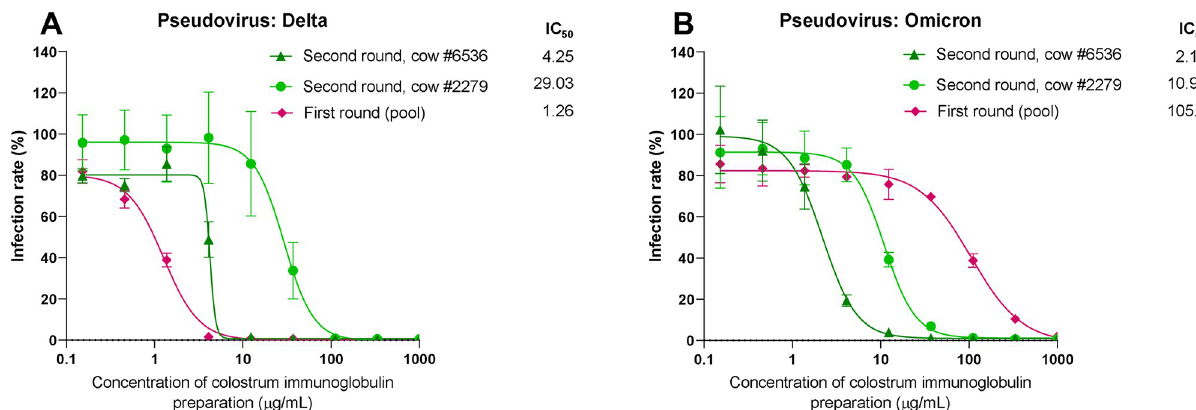
Fig 6. As in Fig 3, the results of the pseudovirus neutralization assay are depicted. Here, pseudoviruses were pseudotyped with either Delta or Omicron VoCs of the SARS-CoV-2 S protein into ACE2-expressing HEK293 cells in the presence of serial dilutions of colostrum immunoglobulin preparations. As described, the rate of cell entry was measured via firefly luciferase activity and expressed as the relative infection rate (%) compared to luciferase activity in the untreated control. Data are represented as the mean ± SD (n = 2–4). The IC 50 concentrations for colostrum immunoglobulin preparation were determined using 4-parameter nonlinear